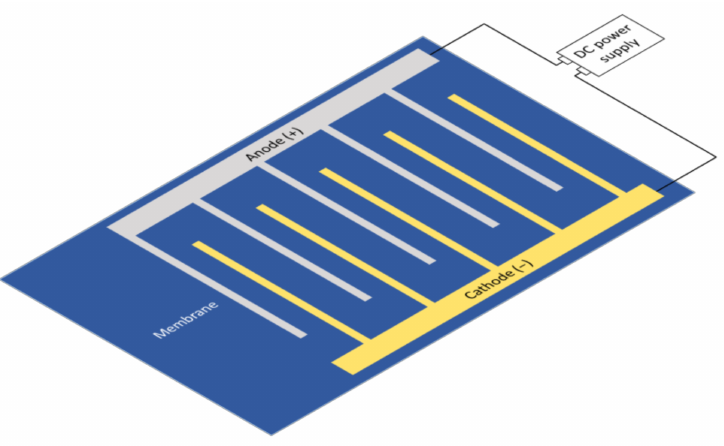
Figure 9. Interdigital electrodes set near the membrane